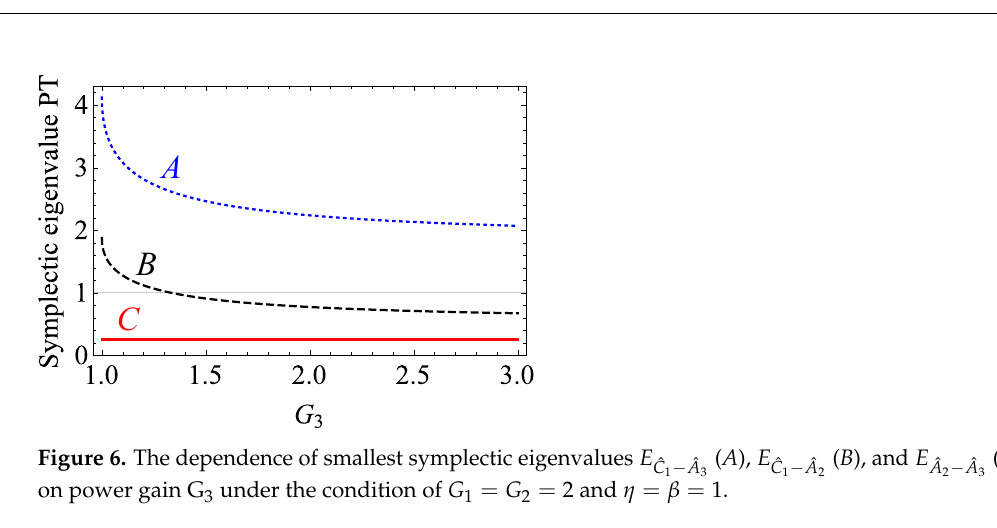
( A ), E ˆ ( B ), and E ˆ ( C ) C 1 − ˆ A 3 C 1 − ˆ A 2 A 2 − ˆ A 3